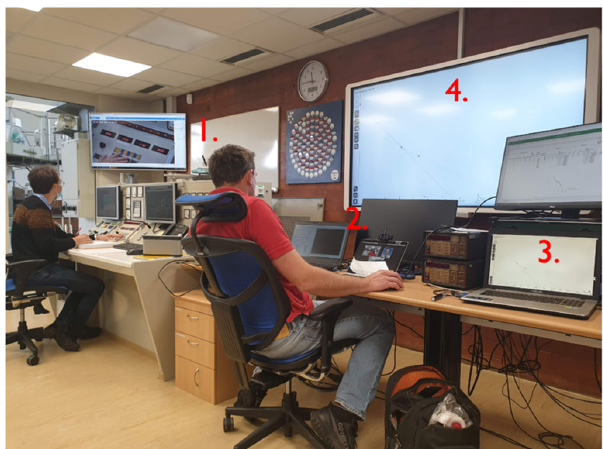
Figure 4 The students are communicating with the reactor operator and the lecturer, observing the operator movements and controlling a shared spreadsheet